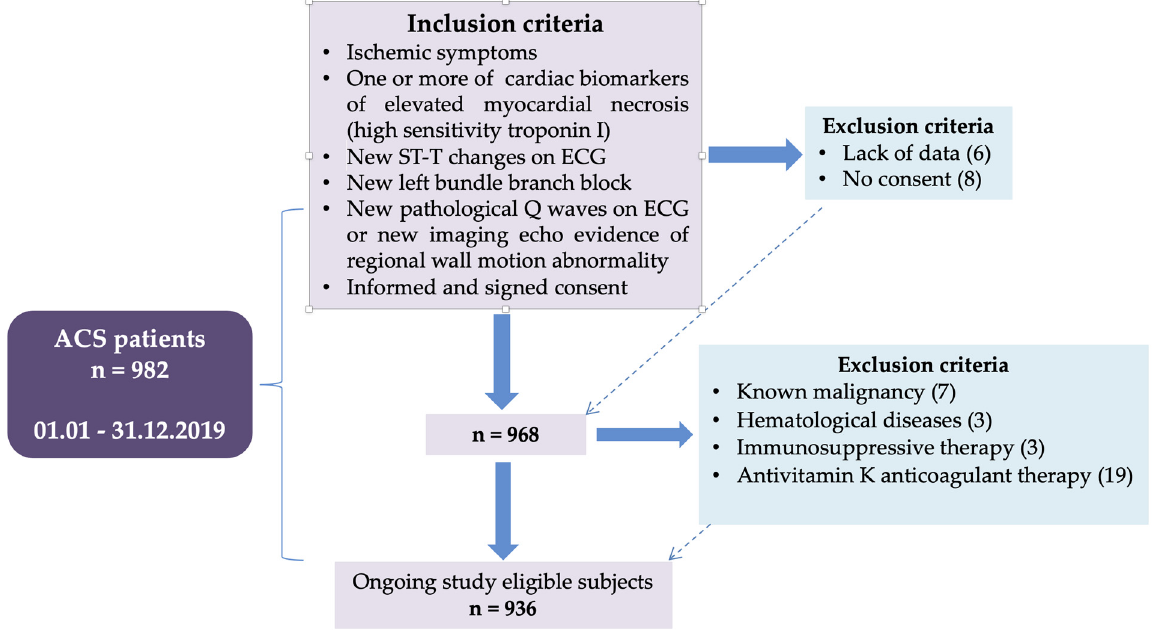
Figure 1. Flow chart presenting the inclusion-exclusion criteria of the